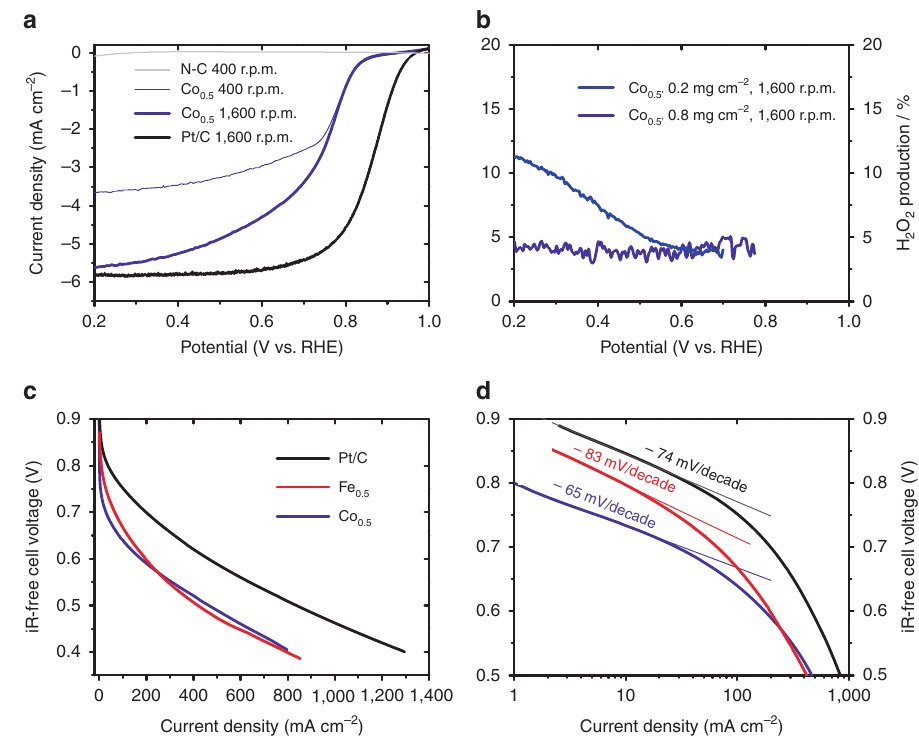
Fig. 2 ORR electrochemical characterization. Measurements of Co 0.5 , Fe 0.5 , N-C and a Pt/C benchmark catalyst. Upper panels are RRDE measurements at various rotation rates and loadings performed in O 2 -saturated 0.1 M H 2 SO 4 aqueous solution. a ORR current density at the disk. The total catalyst loading for Co 0.5 , N-C and Pt/C (5 wt% Pt/C) was 0.8 mg cm − 2 . b % H 2 O 2 measured during ORR at the ring. The total catalyst loading for Co 0.5 was 0.8 or 0.2 mg cm − 2 . Lower panels are iR-corrected PEMFC polarization curves with Co 0.5 , Fe 0.5 or Pt/C at the cathode, presented in linear scale c and semi-logarithmic scale d . The fuel cell temperature was 80 °C, pure H 2 and O 2 gases were fully humidi fi ed at the cell temperature, the gauge pressure was 1 bar. The cathode catalyst loading for Co 0.5 and Fe 0.5 was 4 mg cm − 2 (60 µ g metal per cm 2 ). For Pt/C at the cathode, 5% Pt/C was diluted to 1% Pt with uncatalysed Vulcan carbon black, and 4 mg cm − 2 of 1% Pt/C (40 µ g Pt per cm 2 )